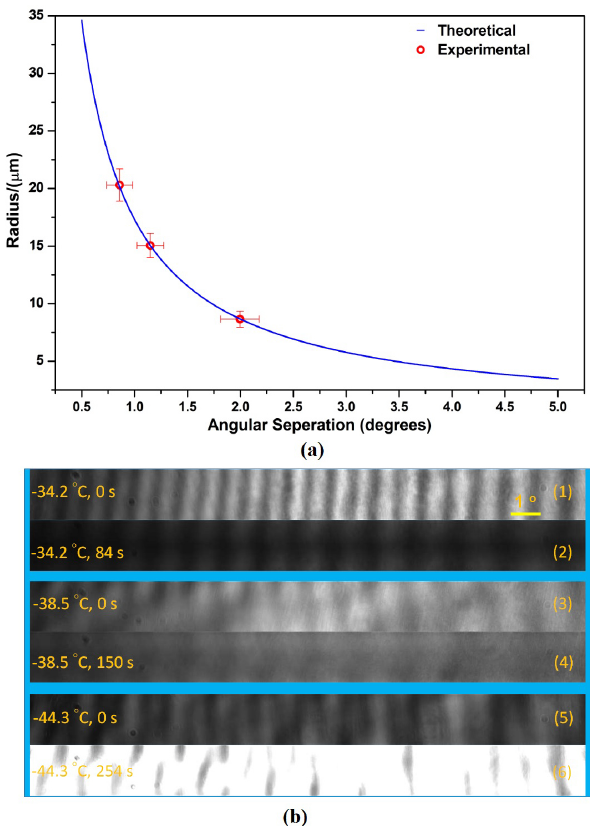
Figure 2. (a) Measurement of particle radius by elastic Mie scat- tering. The size calibration is achieved using calibrated soda lime spheres. Blue line represents the calculated size based on the peak- to-peak spacing using Eq. (1). The experimental points (red circles) are the measured peak-to-peak separations in the recorded diffrac- tion patterns against the quoted size. The uncertainty in the angu- lar separation is the standard deviation (1 σ) in the measurement, and the uncertainty in size is the standard deviation in particle size stated by the manufacturer. (b) Mie scattering of pure SWDs at three different temperatures: − 34 ◦ C, Eqs. (1) and (2); − 38.5 ◦ C, Eqs. (3) and (4); and − 44.3 ◦ C, Eqs. (5) and (6). Droplets at − 38.5 and − 44.3 ◦ C are homogeneously nucleated with irregular scatter- ing patterns. The angular scale bar is the same for all the